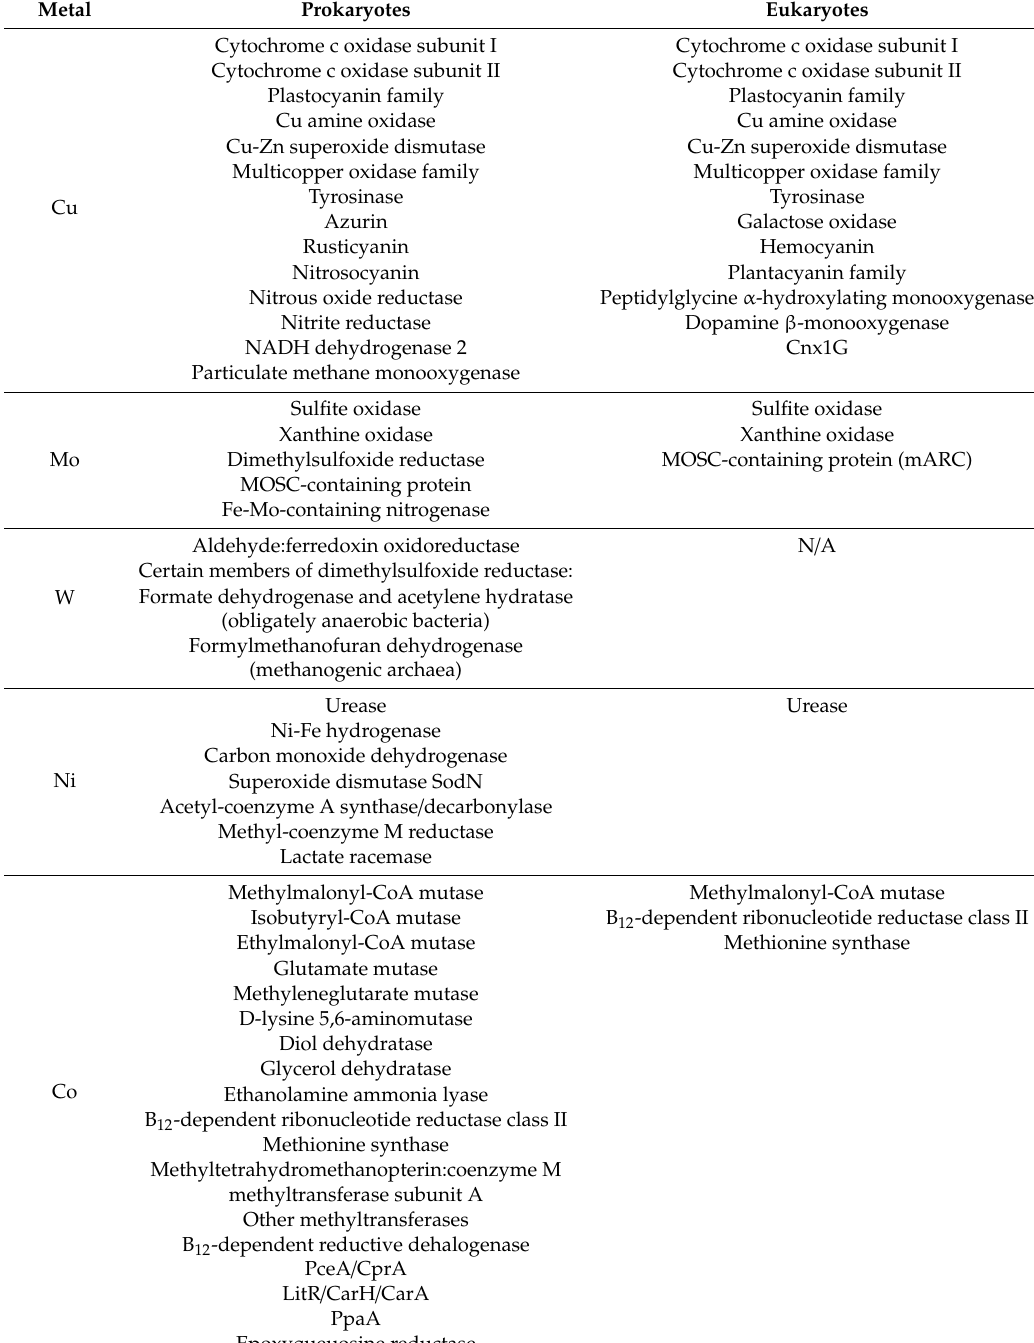
Table 3. List of known metalloprotein families for several metals in prokaryotes and